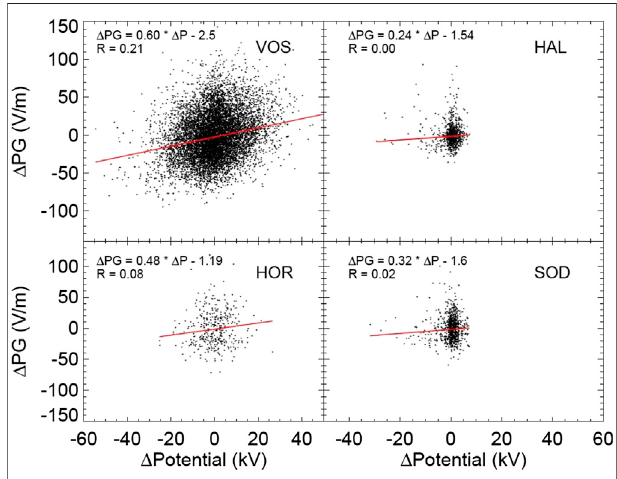
FIGURE 6 | Linear regression analysis of the variation from the mean of the vertical electrical fi eld values and the Weimer model inferred cross polar cap potential difference above VOS, HAL, HOR, and SOD. Here, R indicates the Pearson correlation coef fi cient.